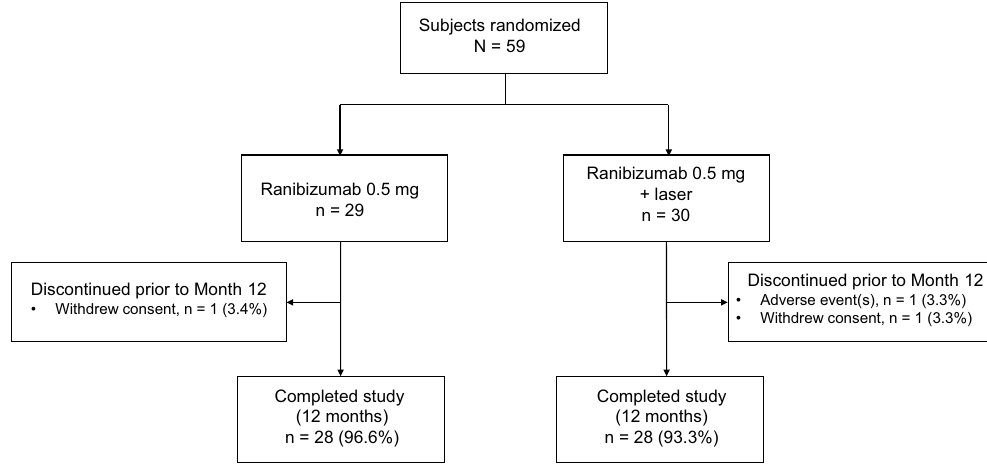
Figure 1. Patient disposition (randomized set).